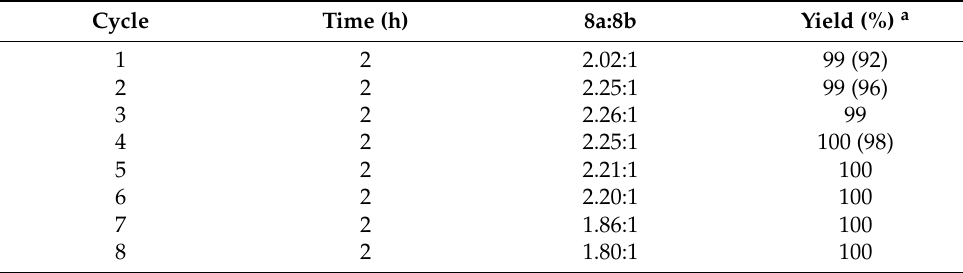
Table 5. Hydrosilylation reaction of phenylacetylene ( 8 ) and triethylsilane ( 3 ) under thermomor- phic